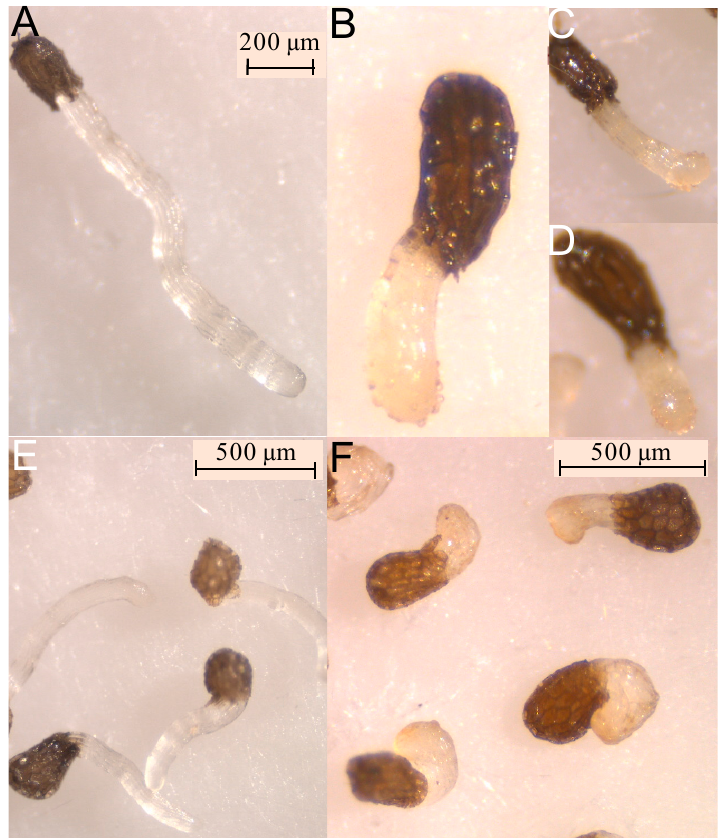
Figure 5. Radicles of O. cumana ( A – D ) and P . ramosa ( E , F ) treated with control ( A , E ) and compound methyl 4-hydroxybenzoate ( 6 ) at 1 mM.